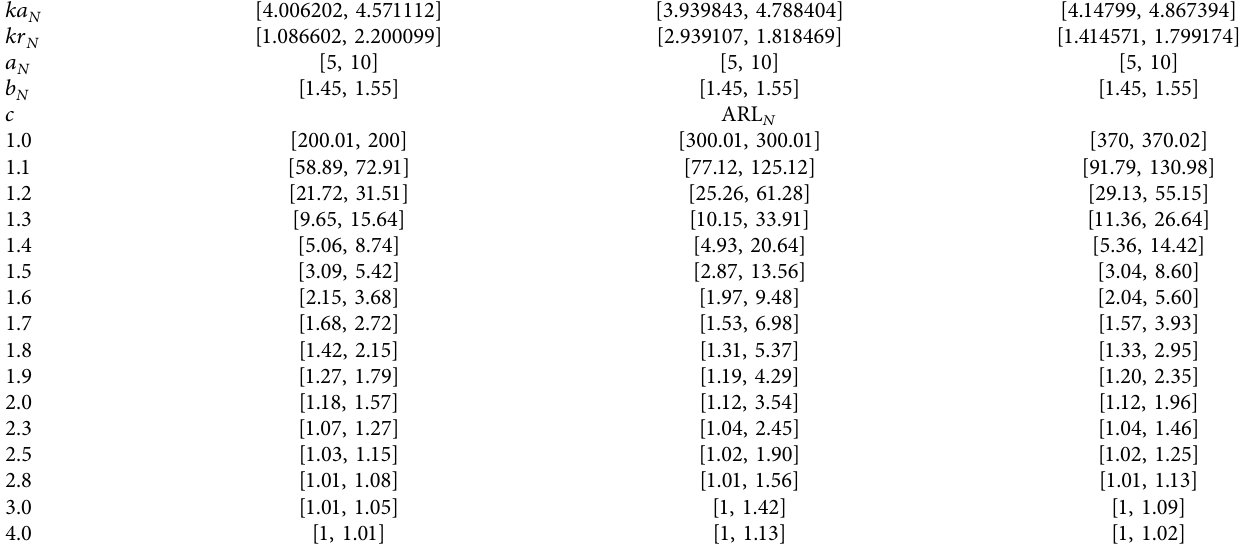
[ 5 , 10 ] and b [ 1 . 45 , 1 . 55 ] N ∈ N ∈